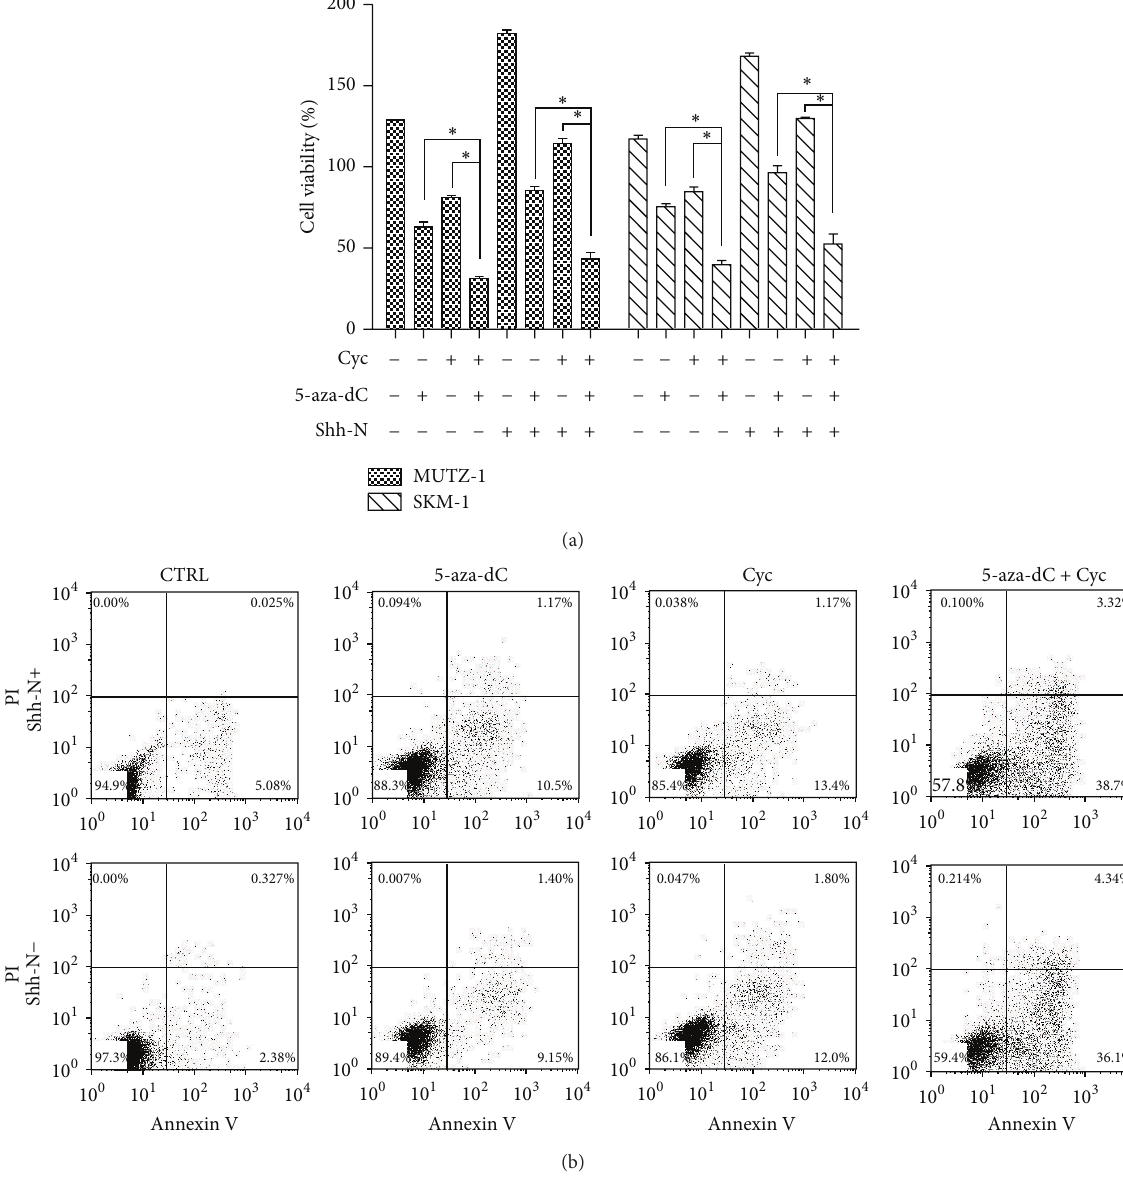
Figure 4: Cyclopamine and demethylating agent 5-aza-dC synergize to induce survival inhibition of MUTZ-1 and SKM-1. MUTZ-1 cells were treated with a combination of cyclopamine and 5-aza-dC or with either agent alone in the presence or absence of Shh-N for 48 h. Cell proliferation and apoptosis were determined using CCK8 assay (a) and Annexin V-PI staining analysis (b), respectively. ∗ 𝑃 < 0.05 . Flow cytometric data are shown from one representative